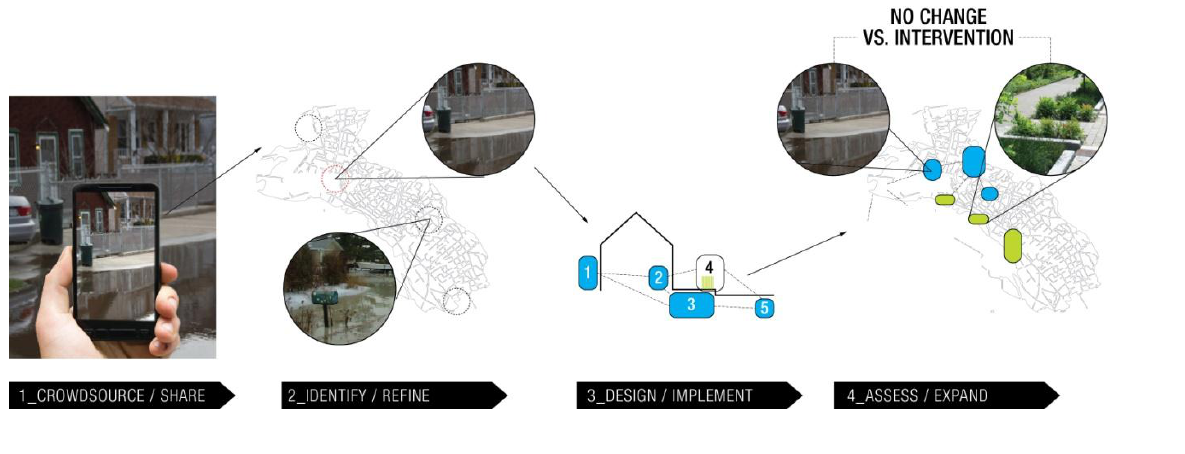
Figure 4. PoroCity Phasing